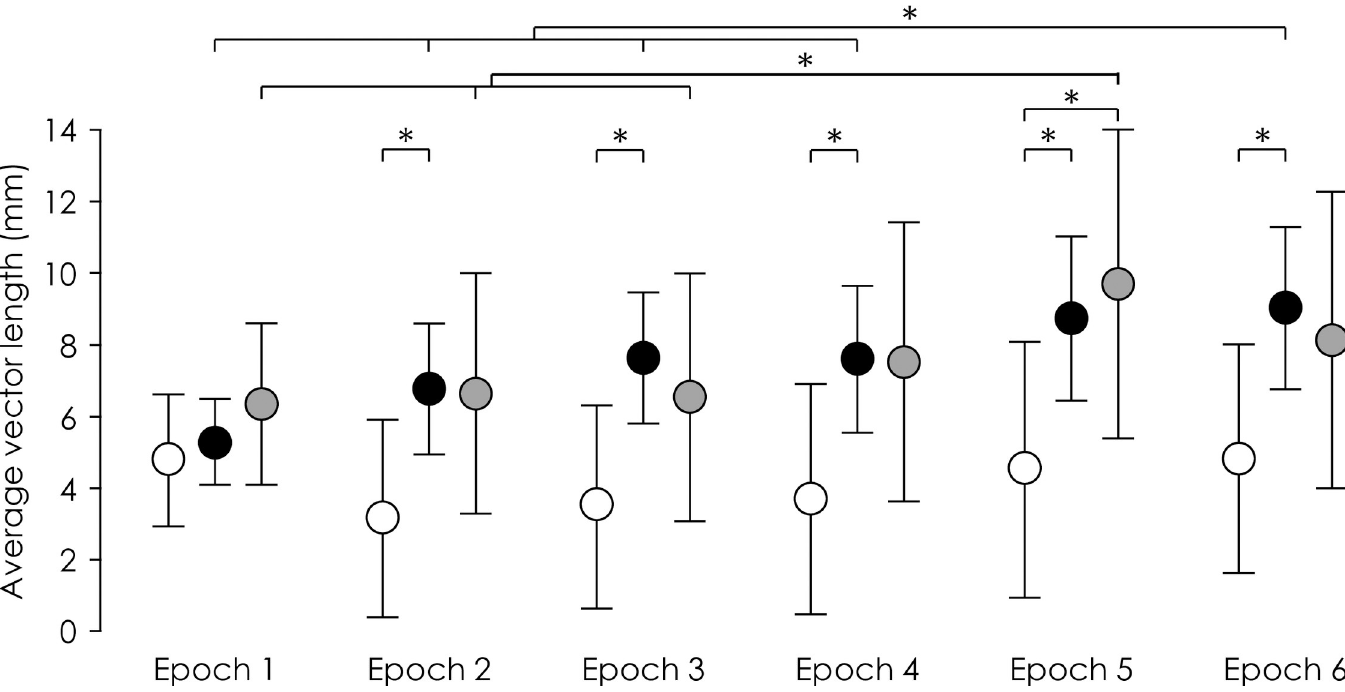
Fig 4. Group data for change of wrist/forearm alignment, quantified as average vector length relative to mean alignment used in Baseline blocks (refer to Fig 3B). Group mean and 95% CI of average vector length of 10-repetition epochs for the Control (white), Pain 5–1 (black), and Pain 5–0 (grey) participant groups are shown. � — p < 0.05 between bracketed